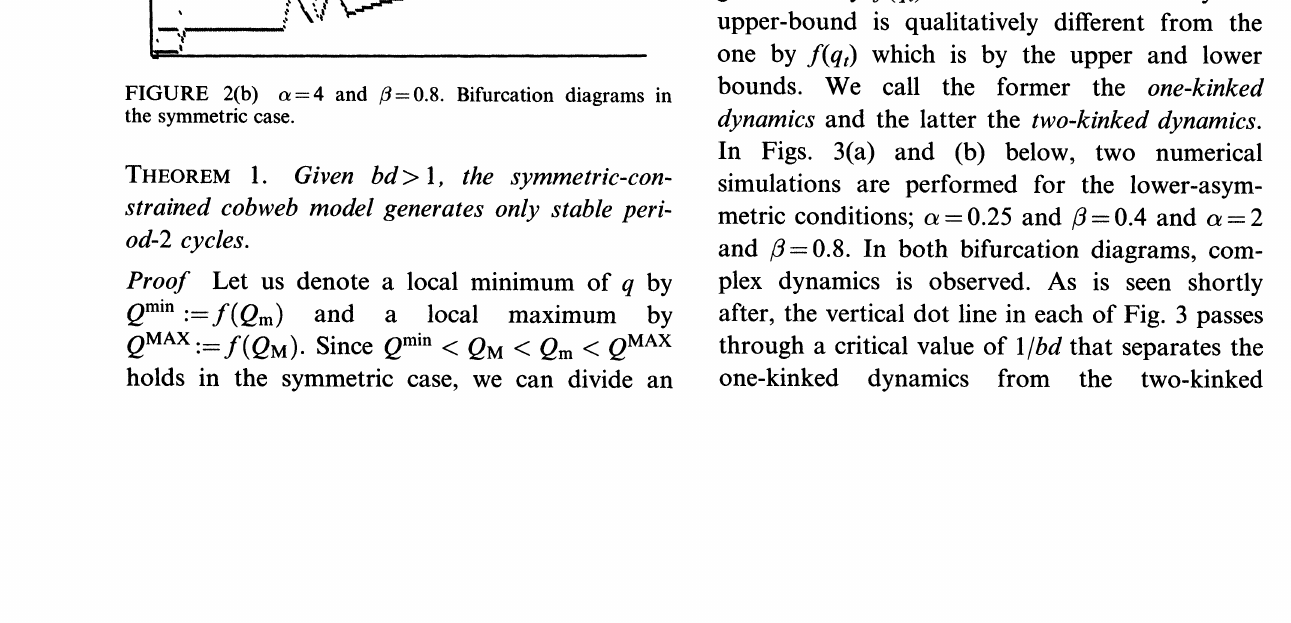
FIGURE 2(a) a=0.1